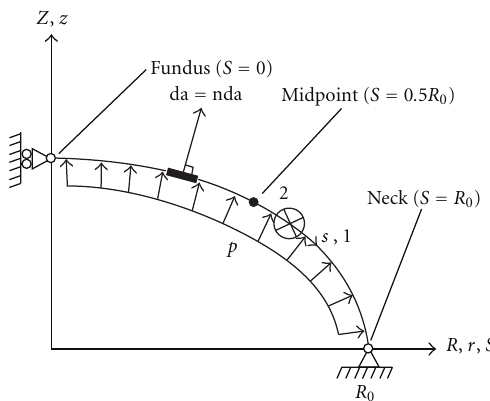
Figure 3: Profile of the membrane, definitions of coordinates and principal directions, and loading and boundary